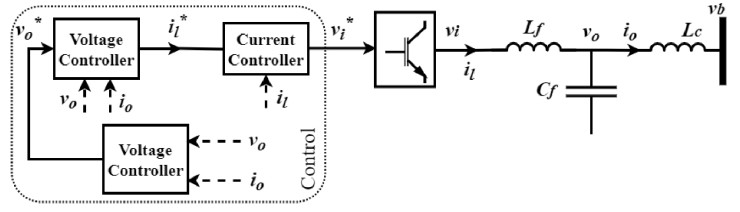
Figure 1. General diagram of DG inverter connected to Microgrids [14].